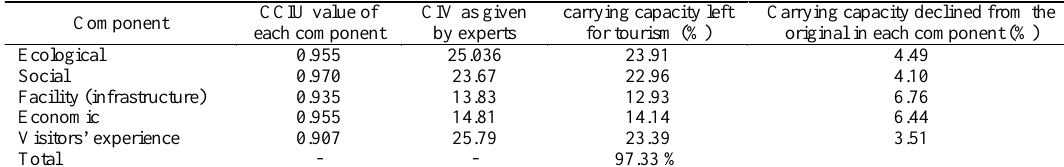
Table 9: Percentage of perceived carrying capacity left for tourism activity in Kerwa tourism area Component